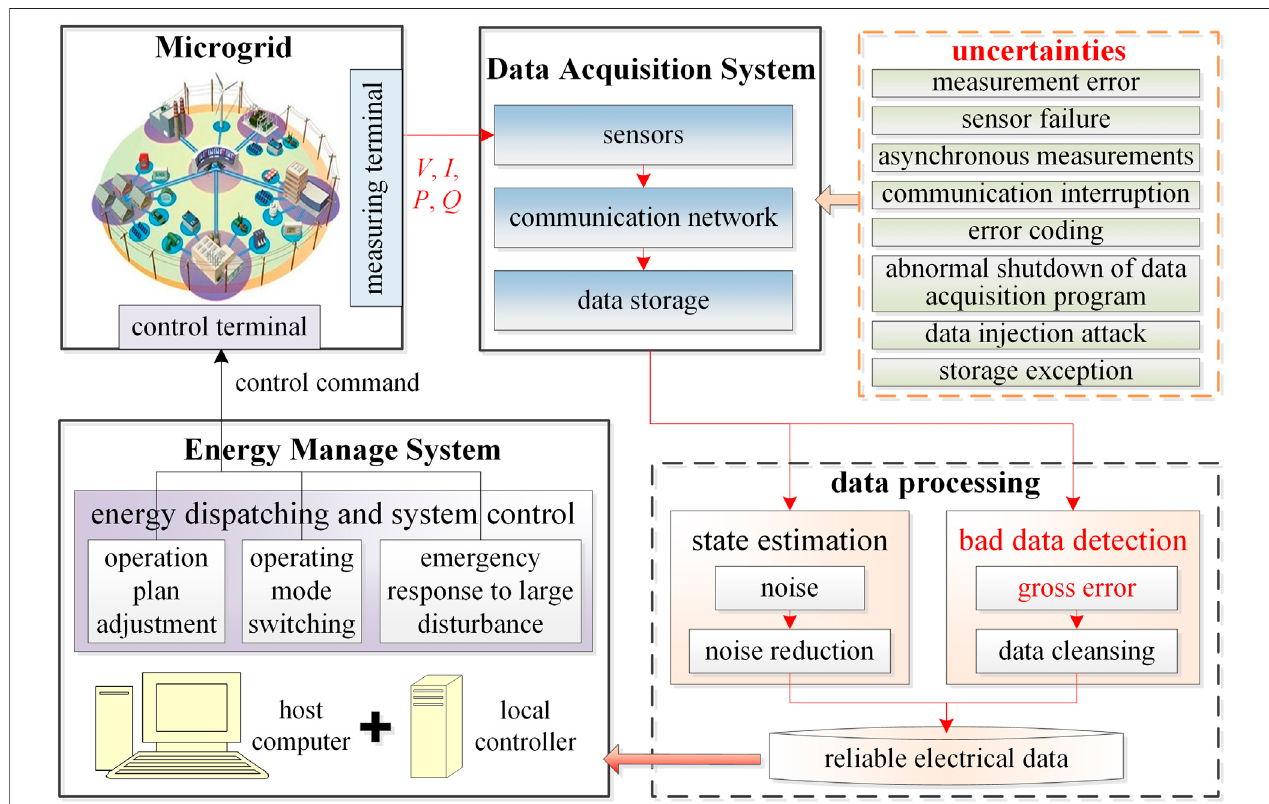
FIGURE 1 | Data measuring, transmission, and processing in